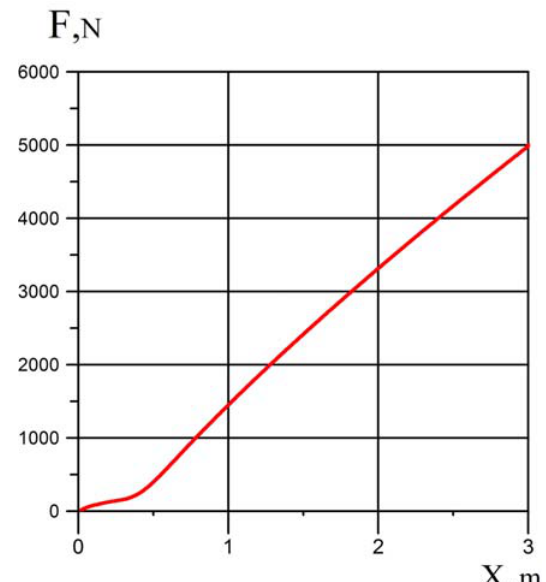
Figure 3 – Calculated dependences of the friction force F of the gas jet on the inner surface of the tubular guide on the displacement X of the nozzle of the projectile’s engine inside the guide (the projectile moves from left to